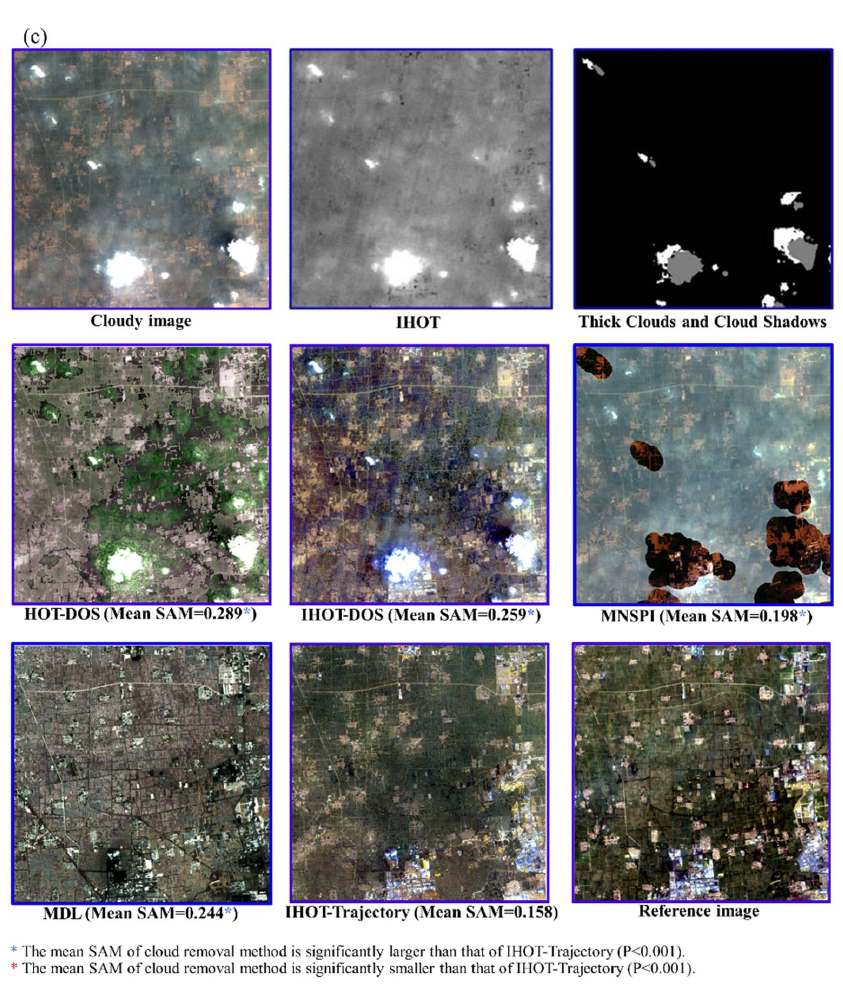
Figure 6. Cloud removal of Landsat image (122/34) acquired at 6 June 2013 ( a ) whole image; ( b ) enlarged images of the subset area; ( c ) enlarged images of the subset area.